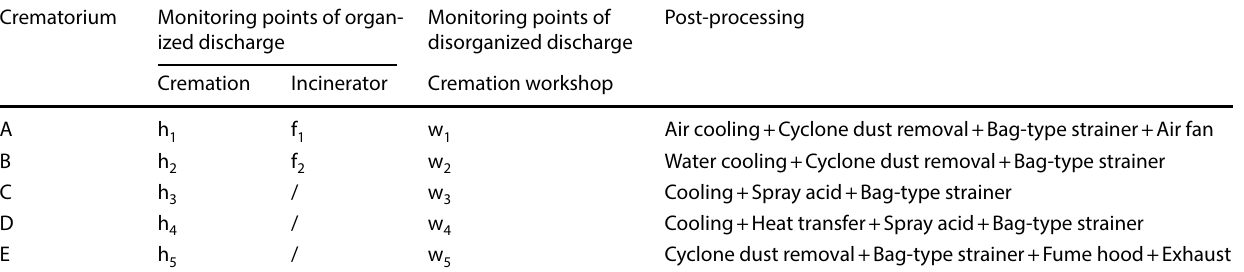
Table 1 Basic information of crematoriums in